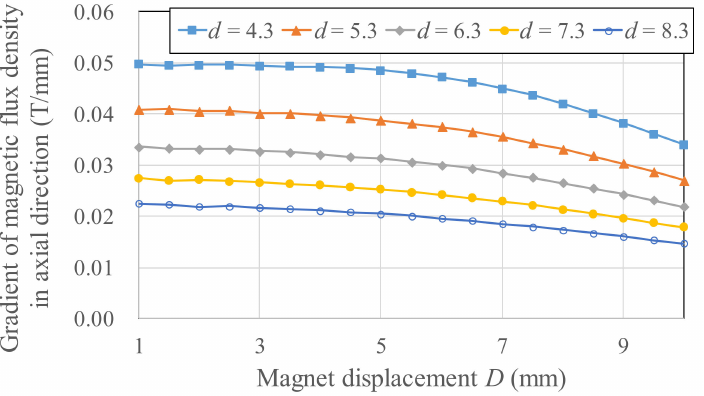
Figure 11. Spatial gradient of the axial average magnetic flux density B w /D for the Wiegand